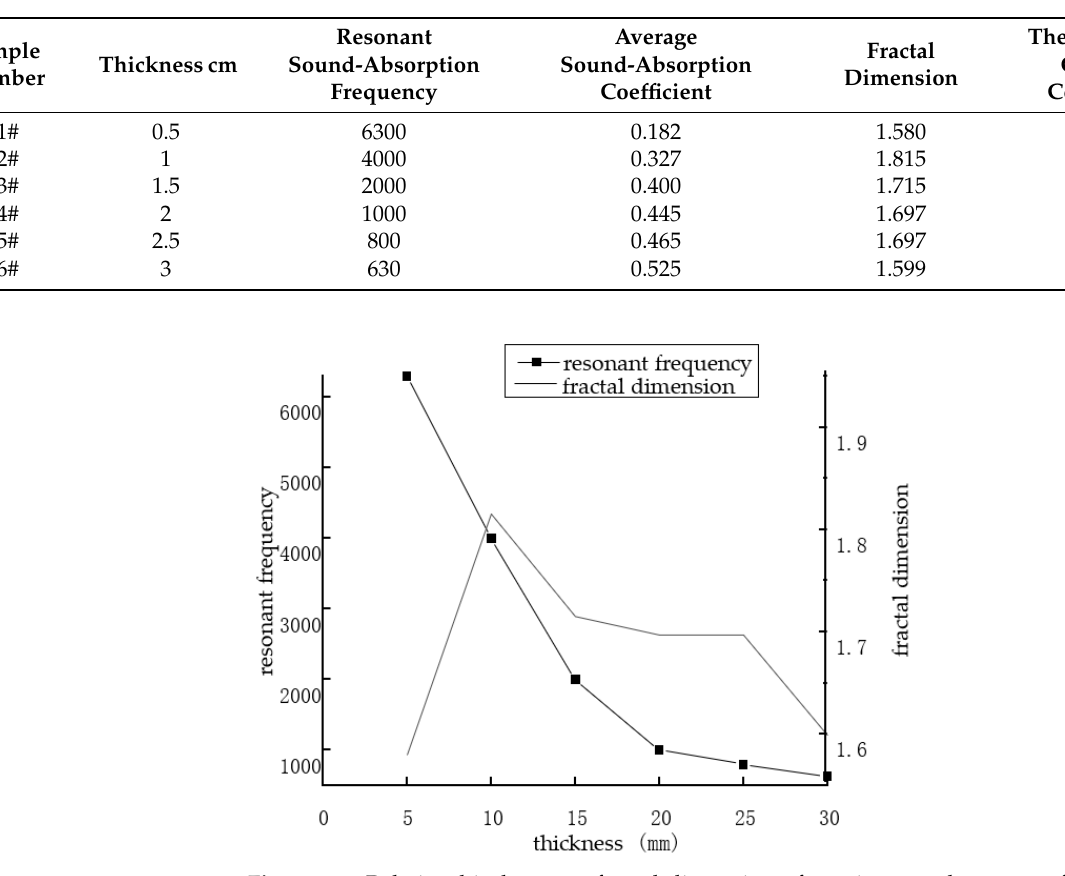
Figure 10. Relationship between fractal dimension of specimen and resonant frequency under different thicknesses.